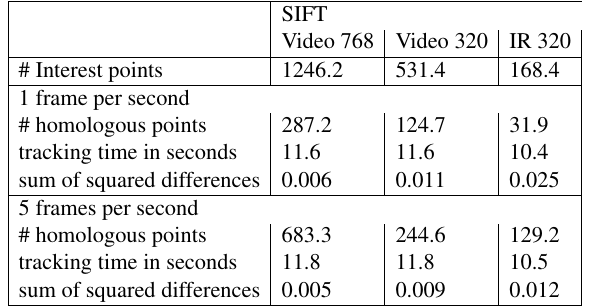
Table 1. Quality of Feature points. Mean values over all se- quences. Number of features in images in the visual spectrum (original resolution and down sampled) compared to number of features in thermal